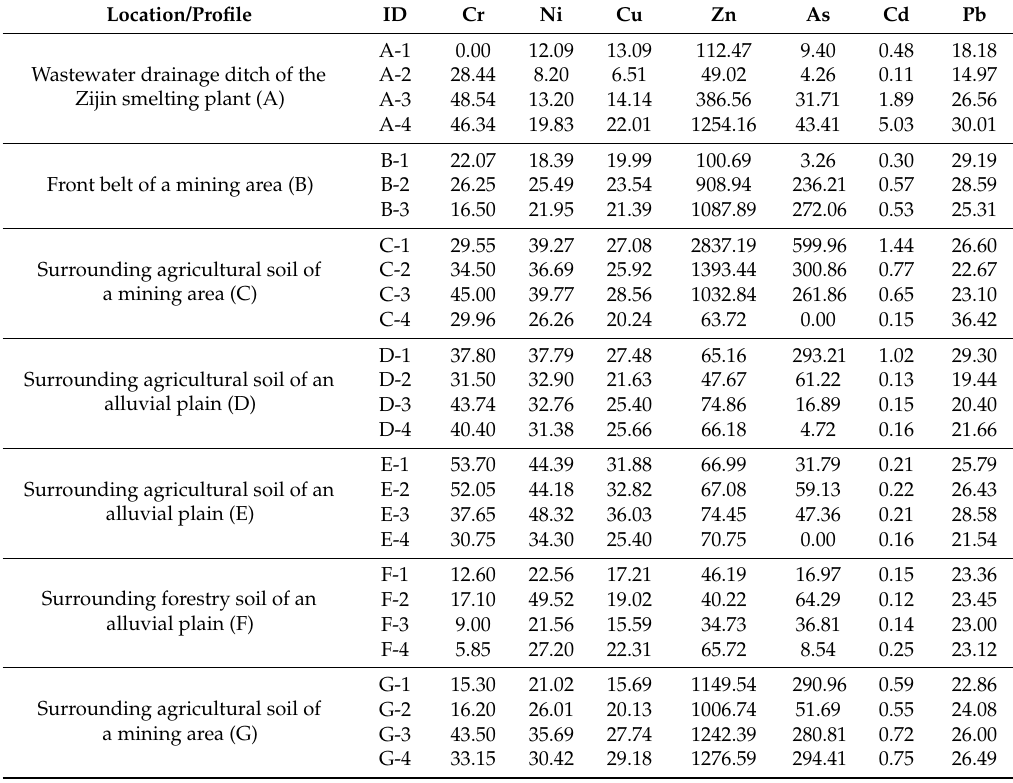
Table 7. The contents of arsenic and heavy metals in the samples for each profile (dry weight, unit: